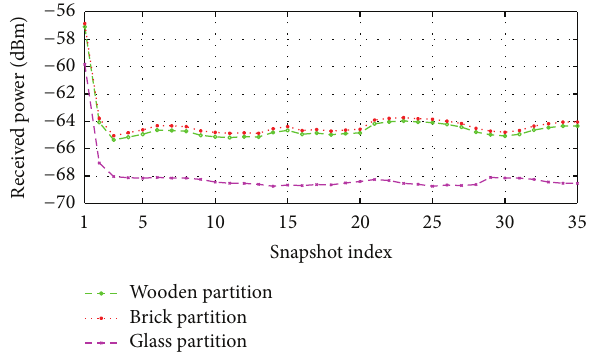
Figure 16: Effect of human body movement on received power when the results taken by considering the inside partitions (red colored) are made of either brick, wood, or glass.